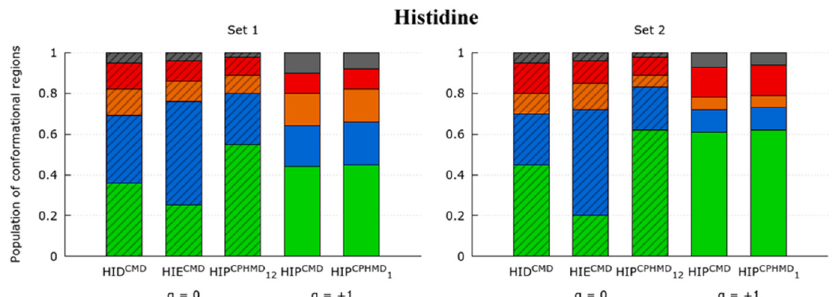
Figure 4. Ratio of the fourth most populated conformational regions (P II , α R , C 7 eq , and C 5 in green, blue, orange, and red, respectively) in the Ramachandran map of the HIS amino acid. Each system indicates the residue, the simulation method (in the superscript), and the pH (in the subscript, only the CPHMD simulations). Subtitles are the set of dihedrals for the monomer 1 (N-terminal) or 2 (C-terminal amino acid). Total charge of the tripeptide is indicated below the systems (q = − 1, 0 or +1). The box style (striped or solid) indicates those systems in the same protonation state, independently of the method used. The ‘others’ classification (gray) includes the conformational regions β 2 , α ’, α D , α L and C 7axial .